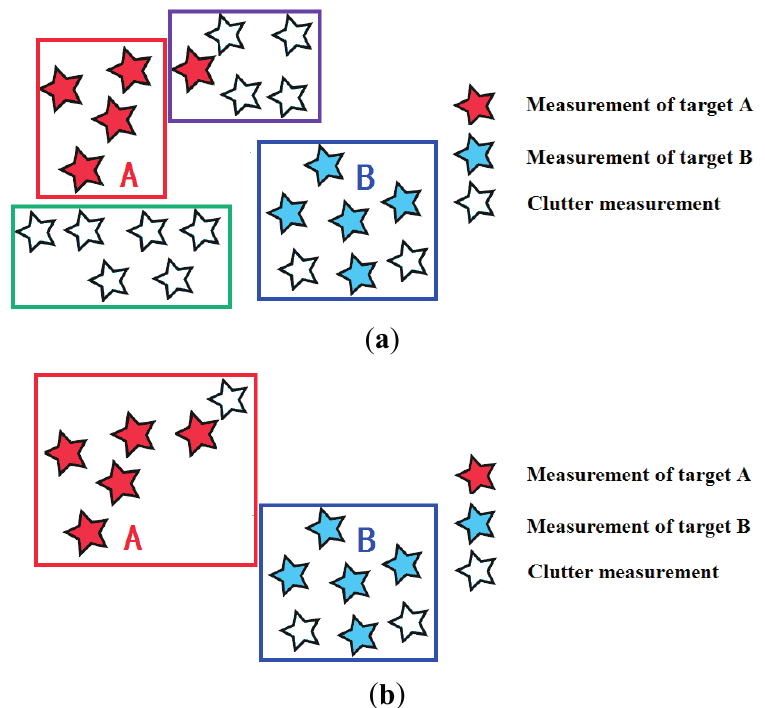
Figure 1. Influence of clutter measurements in partitioning ( a ) Partitioning before clutter removal ( b ) Partitioning after clutter